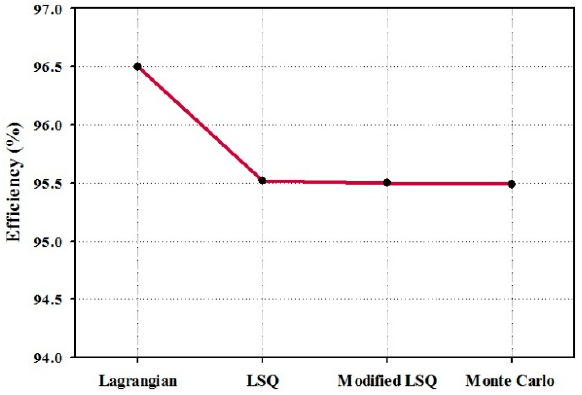
Figure 7. Input and output voltage and current of LLC resonant converter in CCMA.